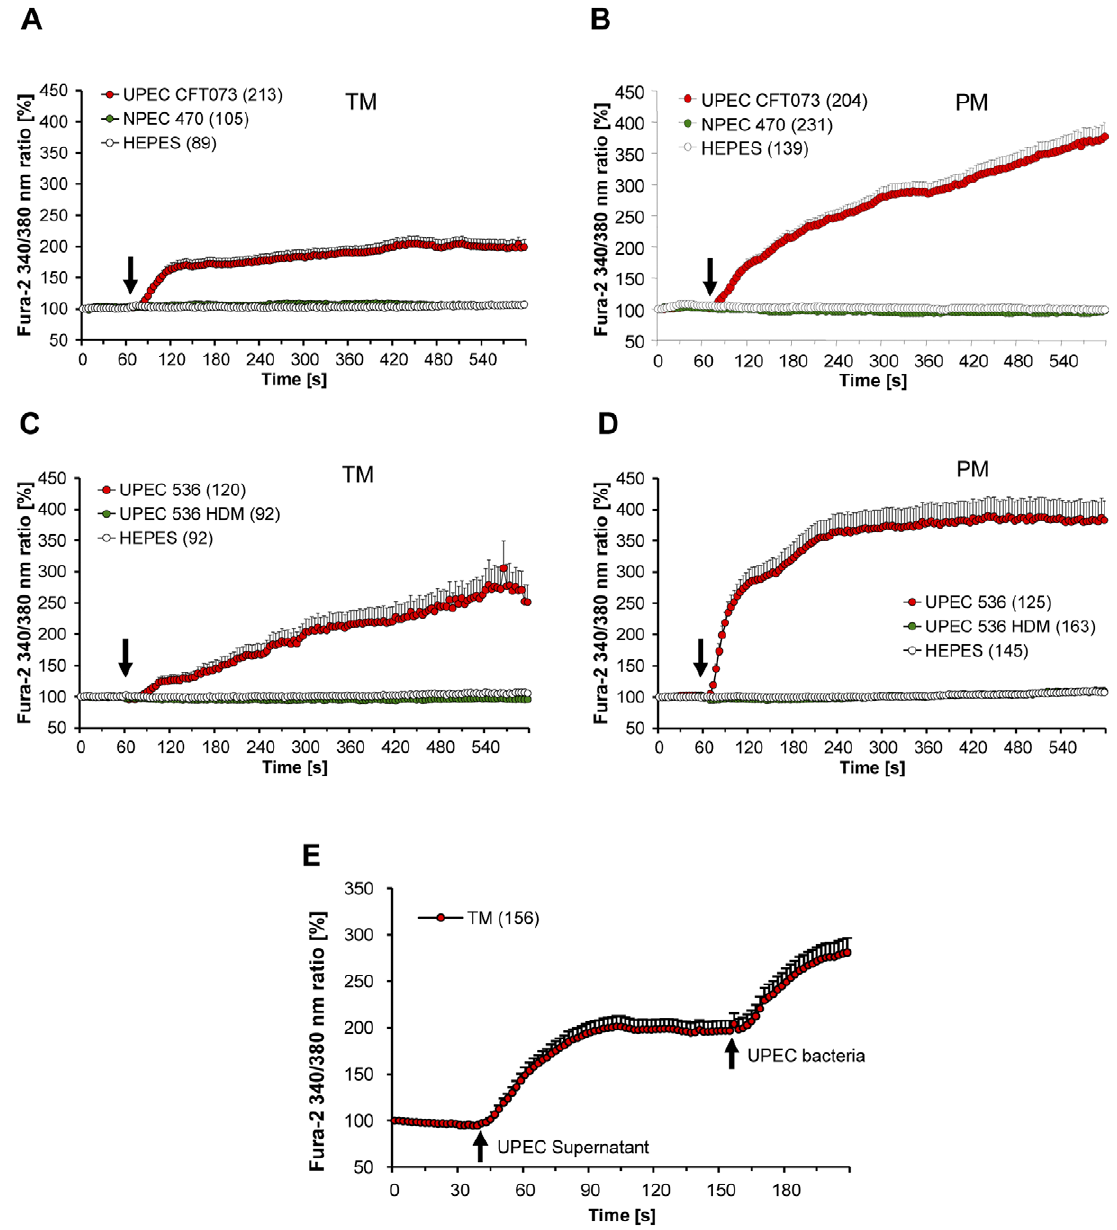
Figure 3. Ca 2 + influx is dependent on presence of hemolysin genes in UPEC. UPEC strains CFT073 and 536 induced a Ca 2 + influx in rat TM ( A, C ) and PM ( B, D ). After recording the baseline ratio of Fura-2 AM fluorescence after excitation at 340 nm versus excitation at 380 nm for 1 min, cells were treated with bacteria or vehicle as indicated by arrows. ( A, B ) PM and TM stimulated with UPEC CFT073 reveal a rapid and sustained increase in [Ca 2 + ] i , while cells treated with vehicle (HEPES) or NPEC 470 do not respond with Ca 2 + mobilization. ( C, D ) UPEC 536 deficient for HlyA (UPEC 536 HDM) were not effective in triggering a Ca 2 + rise, whilst wildtype UPEC 536 elicited a rapid cytoplasmic Ca 2 + influx in both PM and TM. Numbers of measured cells are given in brackets. ( E ) Soluble factor(s) present in the supernatants induced a rise in [Ca 2 + ] i . UPEC bacteria were added as a positive control at the end of the experiment and caused further elevation of [Ca 2 + ] i levels. Intracellular Ca 2 + was monitored by the Fura-2 method. Areas under the curve were calculated by summing up values obtained for each cell. Non-parametric rank based Kruskal-Wallis test was used to compare multiple groups and if significant differences were detected, it was followed by Mann-Whitney test to compare between two experimental groups. doi:10.1371/journal.pone.0028452.g003 (60 min) (Table 3, Table S2A, S2B). On the other hand, the signaling pathways in both TM and PM highlighting the differentially regulated genes in TM showed an early but sustained involvement of intracellular Ca 2 + rises during infection with UPEC upregulation of genes involved in both pro- and anti-inflammation (Table S3). Therefore, we used the Ingenuity Pathways Analysis tool and calcium homeostasis (Table 3, Table S2C, S2D). Interestingly, (Ingenuity H Systems) to identify genes/pathways centrally involved the data analysis revealed a multitude of genes implicated in calcium in cellular calcium signaling. We identified NFAT as a key molecule